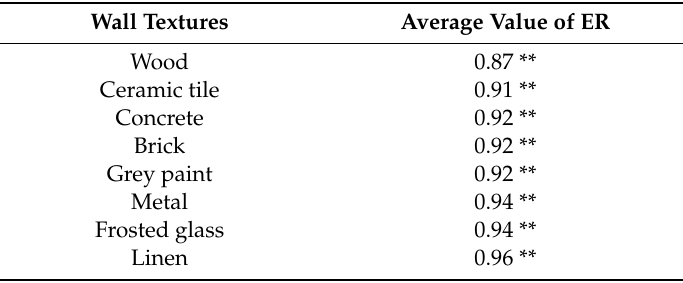
Table 1. Result of Experiment 1 using the Mann–Whitney U test.